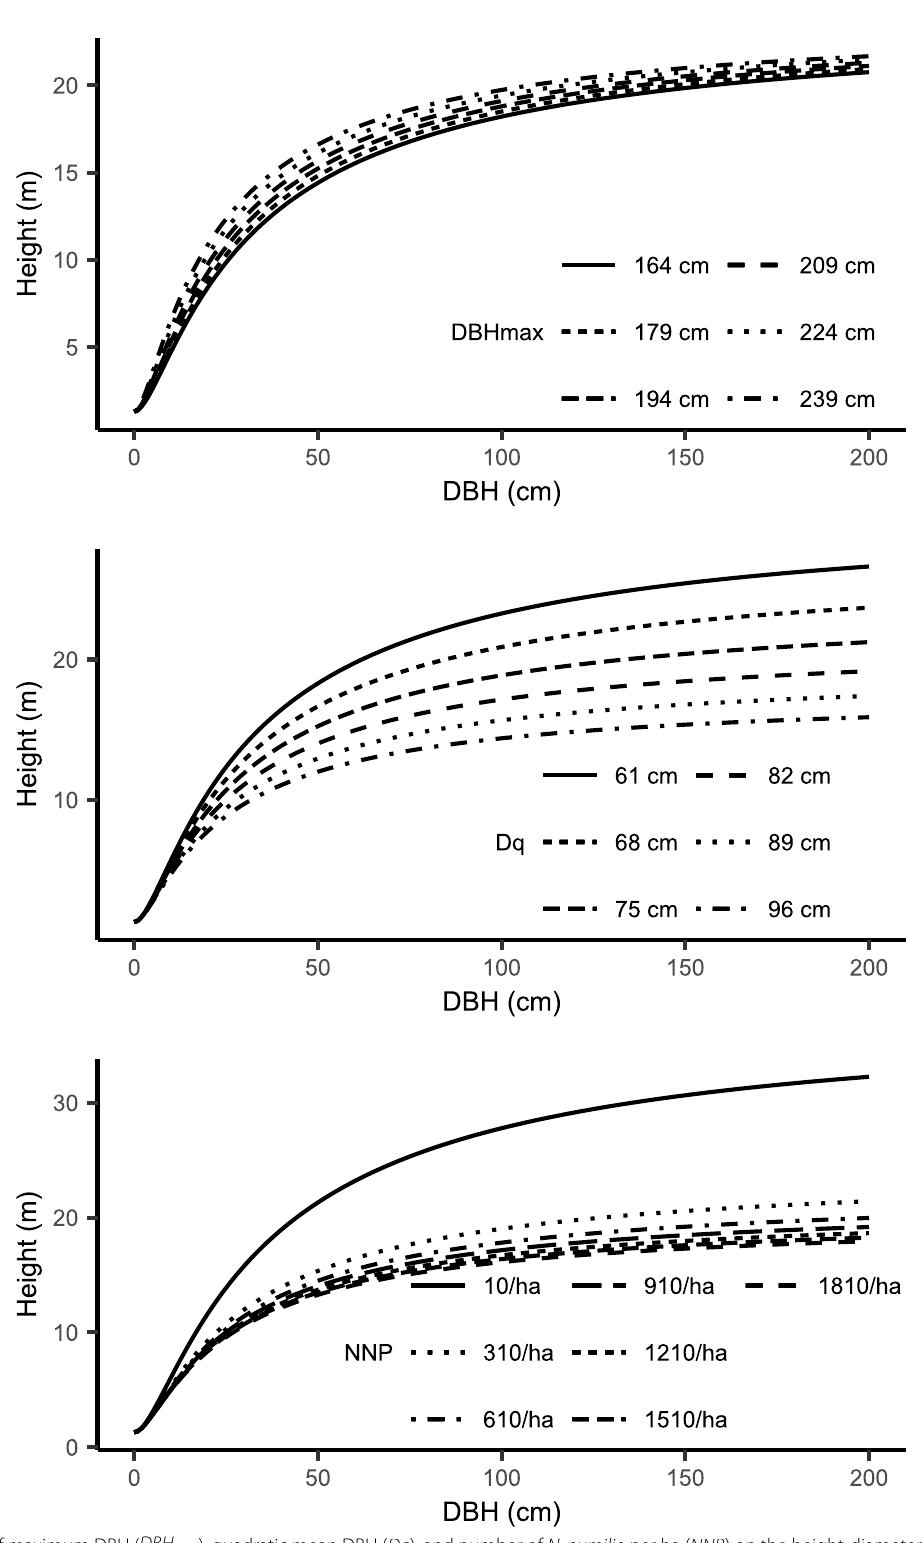
Fig. 7 Effects of maximum DBH ( DBH max ), quadratic mean DBH ( Dq ), and number of N. pumilio per ha ( NNP ) on the height-diameter relationships of N. pumilio . The curves were produced from the parameter estimates obtained when fitting Eq. 3. The values of the stand variables were replaced using the mean value except for the stand variable of interest, which slowly varied from the minimum to the maximum at the same